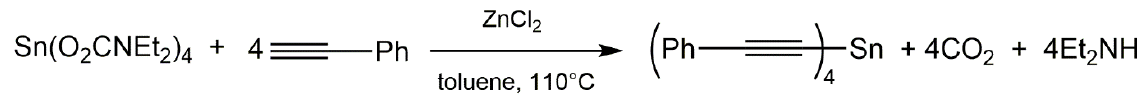
Scheme 12. Reaction of tetrakis( N , N -diethylcarbamato)tin(IV) with phenylacetylene leading to tetra(phenylethynyl)tin, data from [47].